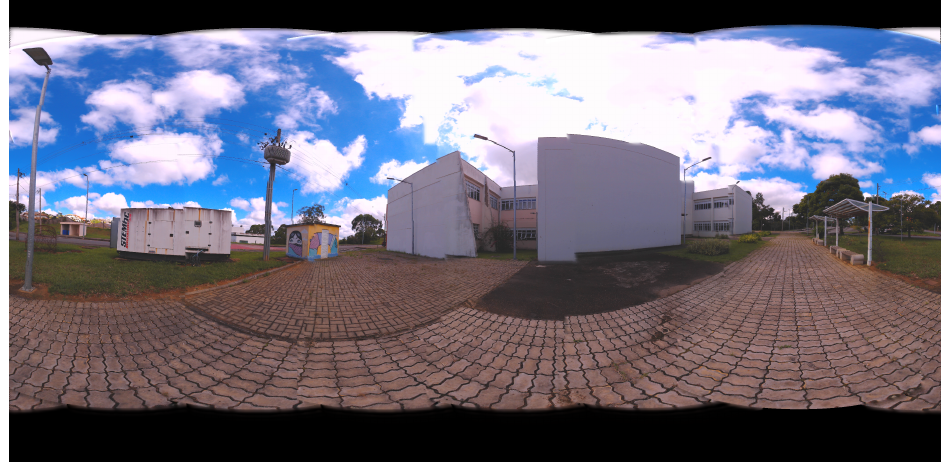
Figure 17. 360 Panoramic Image Resulting from the best method for Case Study II : Particle Swarm Optimization